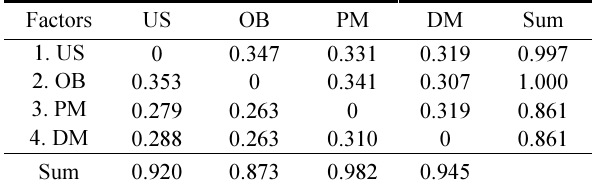
Table 8. Direct influence matrix D of factors